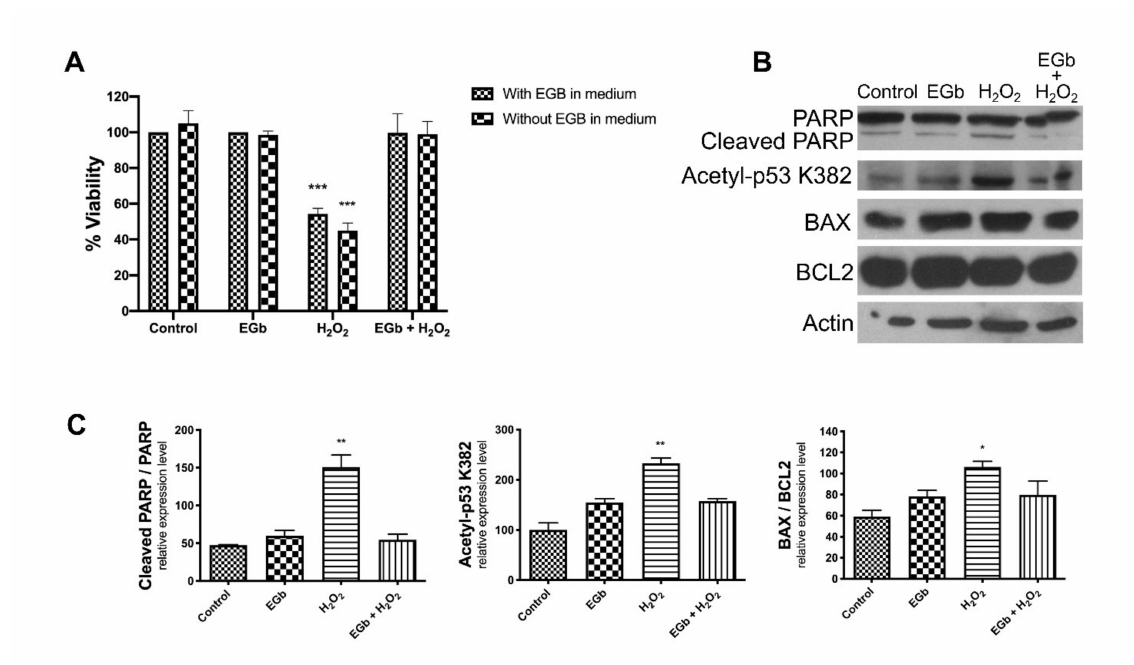
Figure 5. Intracellular e ff ect of EGb. Cell viability analysis of SK-N-BE with or without EGb in the medium after H 2 O 2 oxidative insult ( A ). Protein expression analysis of cleaved PARP, Acetylated-p53 / K382, BAX and Bcl2 in SK-N-BE cells after treatments by Western blot analysis ( B ). Histograms report the expression of Acetylated-p53 / K382, cleaved PARP and BAX / Bcl2 ratio normalized expression ( C ). β -Actin was used as loading control. The bars represent ± the average ± SD of independent experiments ( n = 3). Statistically significant di ff erence compared to control cells: * p ≤ 0.05, ** p ≤ 0.01, *** p ≤ 0.005). Cells treated with DMSO were used as